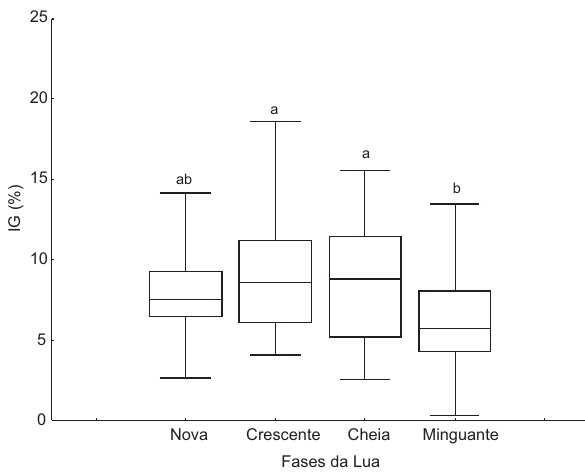
Os ouriços entre 8 e 23 mm não apresentaram gônadas (Fig. 5). O primeiro diâmetro que apresenta indivíduos com gônada é de 23,30 mm. A presença de gônada em 50% dos animais ocorre em indivíduos de 28,22 mm e em 100% dos animais ocorre em indivíduos maiores que 69,90 mm.